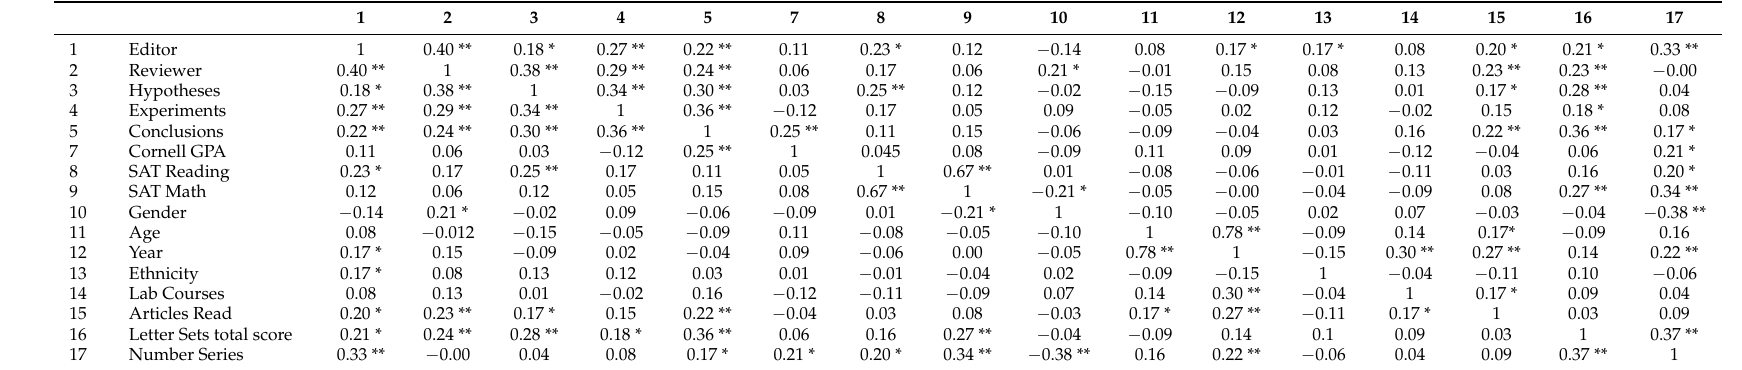
Table 10. Intercorrelations in Study